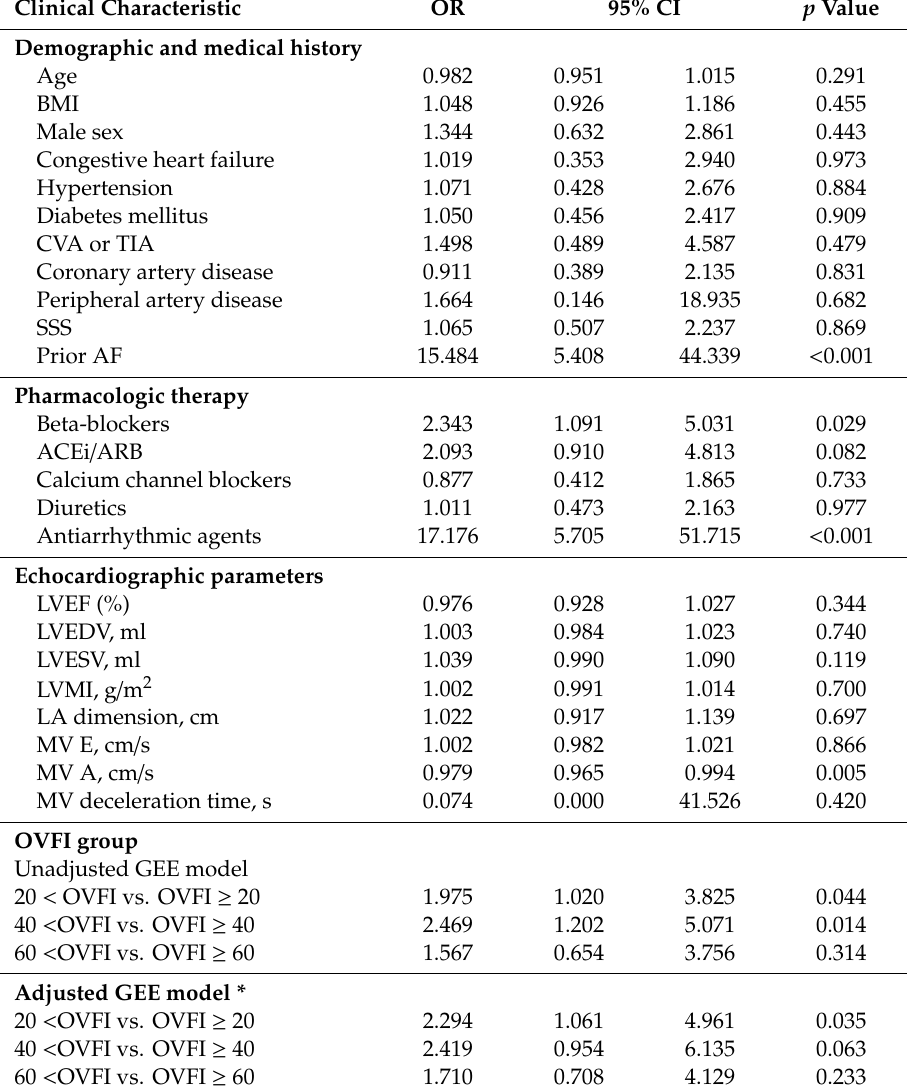
Table 3. Factors associated with AT / AF episodes more than 4